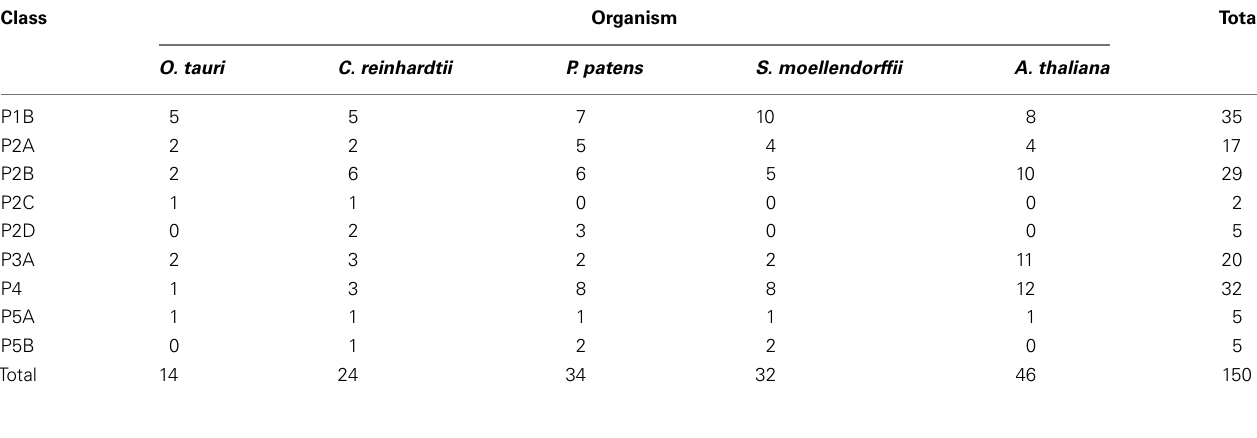
Table 1 | Overview of number of pumps in different P-typeATPase subfamilies inViridiplantae. Class